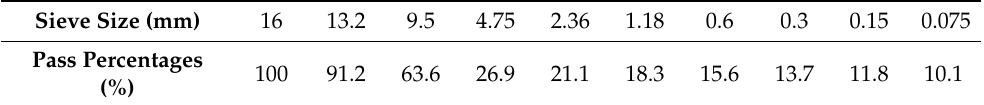
Table 1. Aggregate